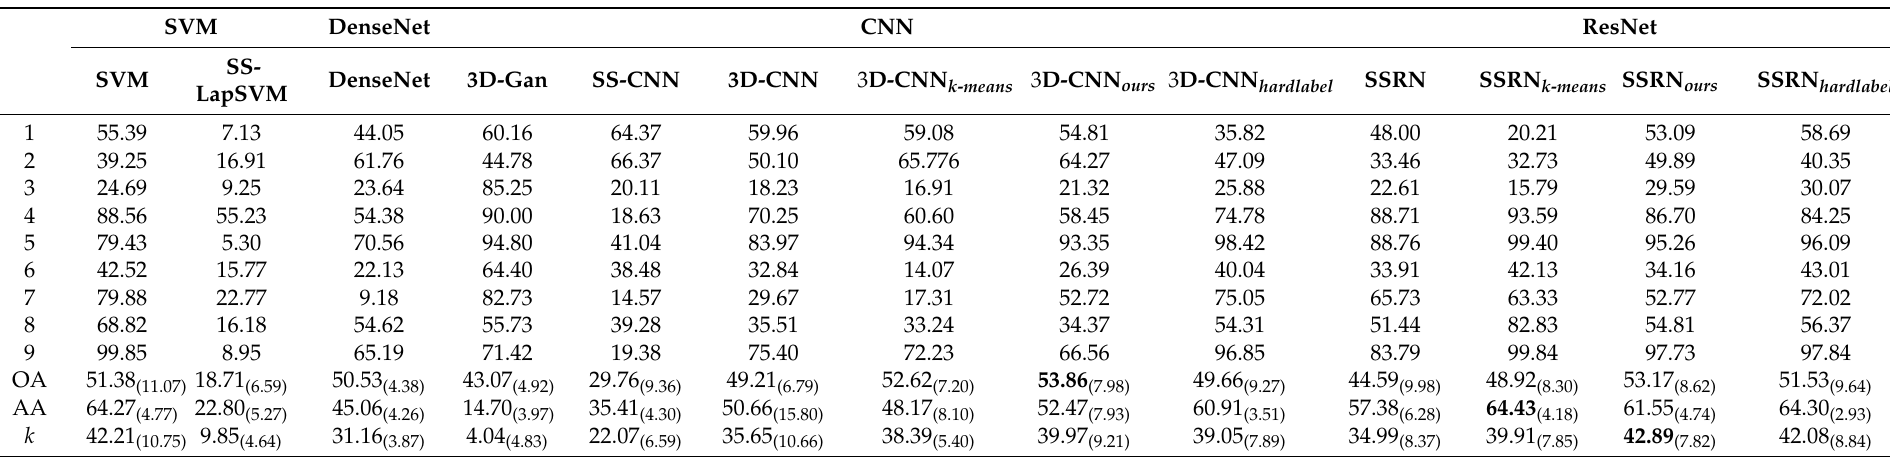
Table 8. Classification accuracy (%) for all methods with one training samples on the PaviaU